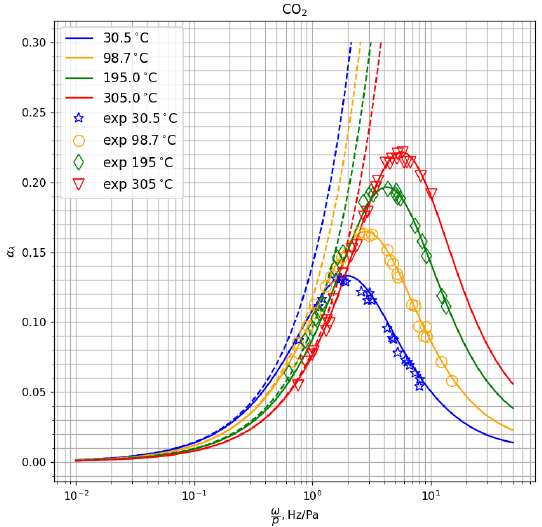
Figure 7. Attenuation coefficient in CO 2 for different temperatures and p = 1 atm. Solid lines: our 2T model; dashed lines: 1T model with the bulk viscosity from [41]; symbols: experiment